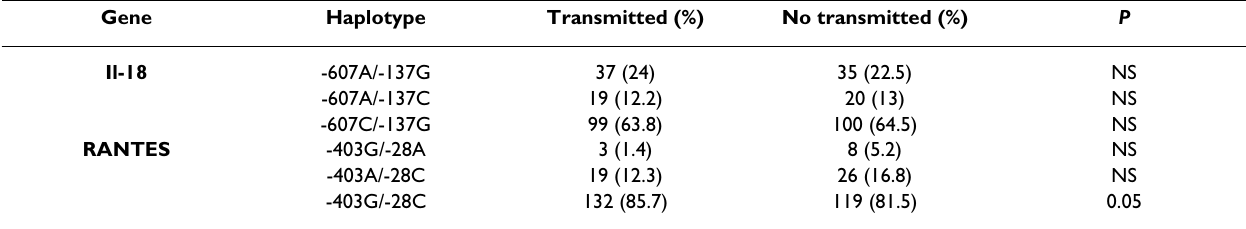
Table 3: Transmission pattern of haplotypes inferred for IL-18 and RANTES promoter genetic variant in CD families